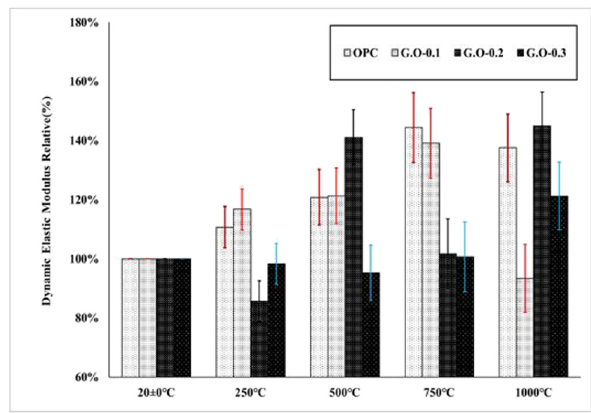
Figure 10: Dynamic elastic modulus relative ( % ) at di ff erent temperatures.